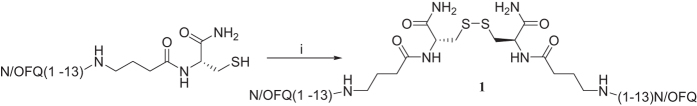
Synthesis of homodimer 1: (i) CH3CN/H2O 50:50, NaHCO3 (cat), rt, 12 h. Compounds 2–9, 11, 13 were obtained under the same experimental conditions starting from the corresponding monomer.